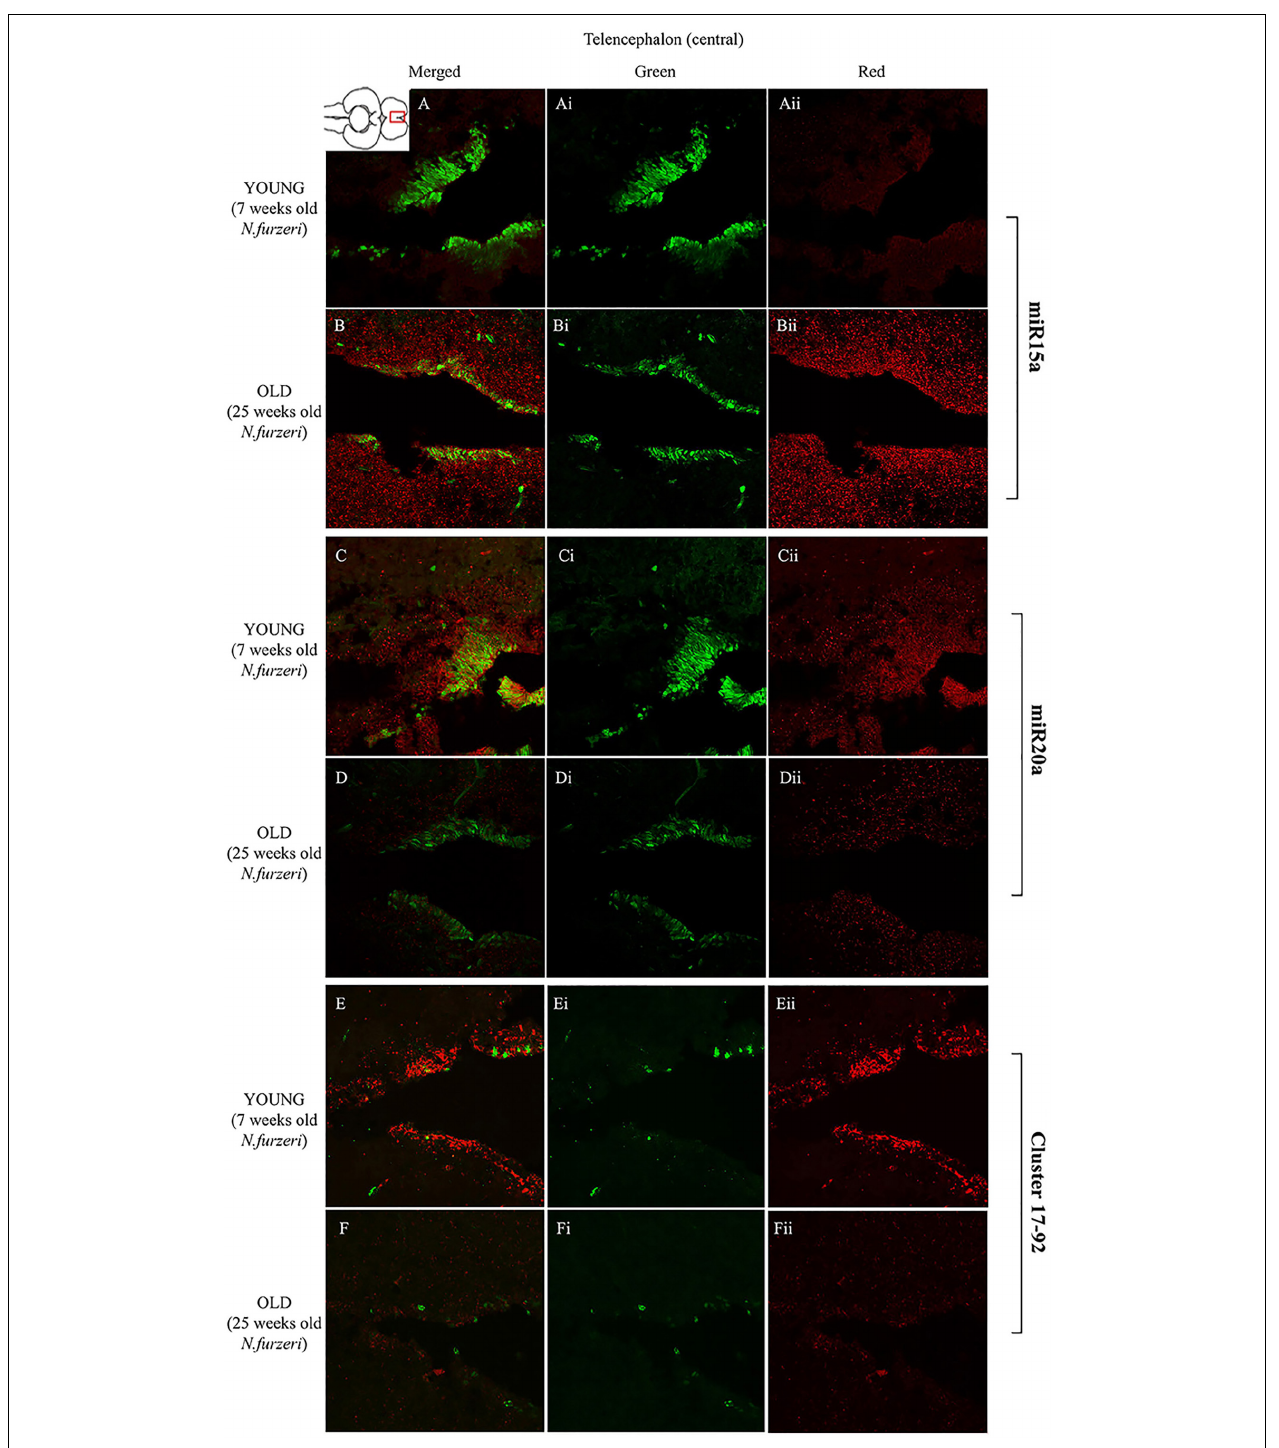
FIGURE 5 | Magnification of the latero-posterior region of the telencephalon (lpTEL) stained in green for PCNA by IHC, and in red for miR15 (A,B strips), miR20 (C,D strips), and Cluster17–92 (E,F strips) by ISH. The lower inset on Aii shows an overview of a horizontal brain section: the location of the lpTEL is indicated by the red rectangle.The left column of the panel ( A – F ) shows the merged channels for the double staining; A,B refer